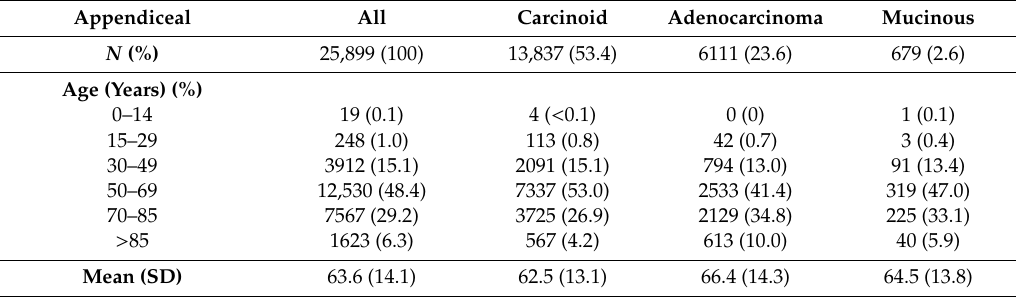
Table 17. Baseline demographics and clinical characteristics by histology for small bowel cancers.